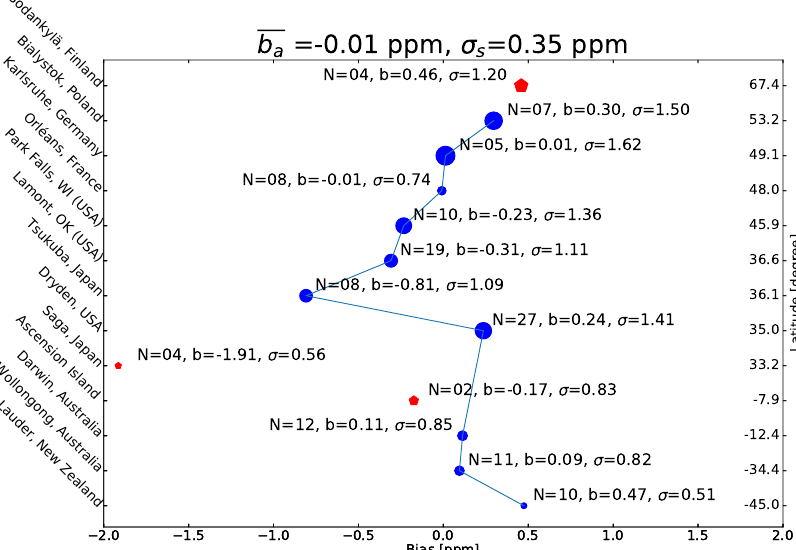
Figure 8. The dependence of the bias between RemoTeC/OCO-2 target X CO retrievals coincident with TCCON data on the latitude of each 2 station. Shown are the averaged results for bias-corrected X CO retrievals. Stations with less than five collocation points (marked with red 2 pentagon) should be interpreted with care and are therefore excluded from the calculation of the derived parameters including mean bias ( b a ) and the station-to-station variability ( σ s ). For each station, number of valid points ( N ), bias ( b ) and SD ( σ ) are listed next to the dot point. The size of each dot represents the SD of the difference at each station.